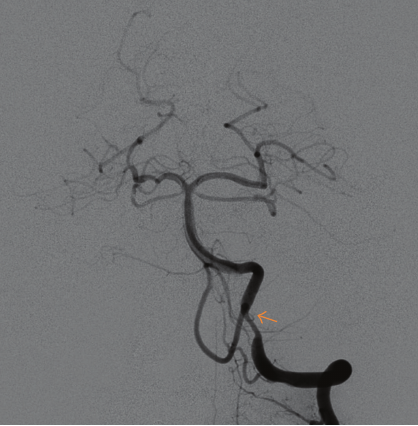
Figure 2: Left vertebral artery angiogram demonstrating stenosis